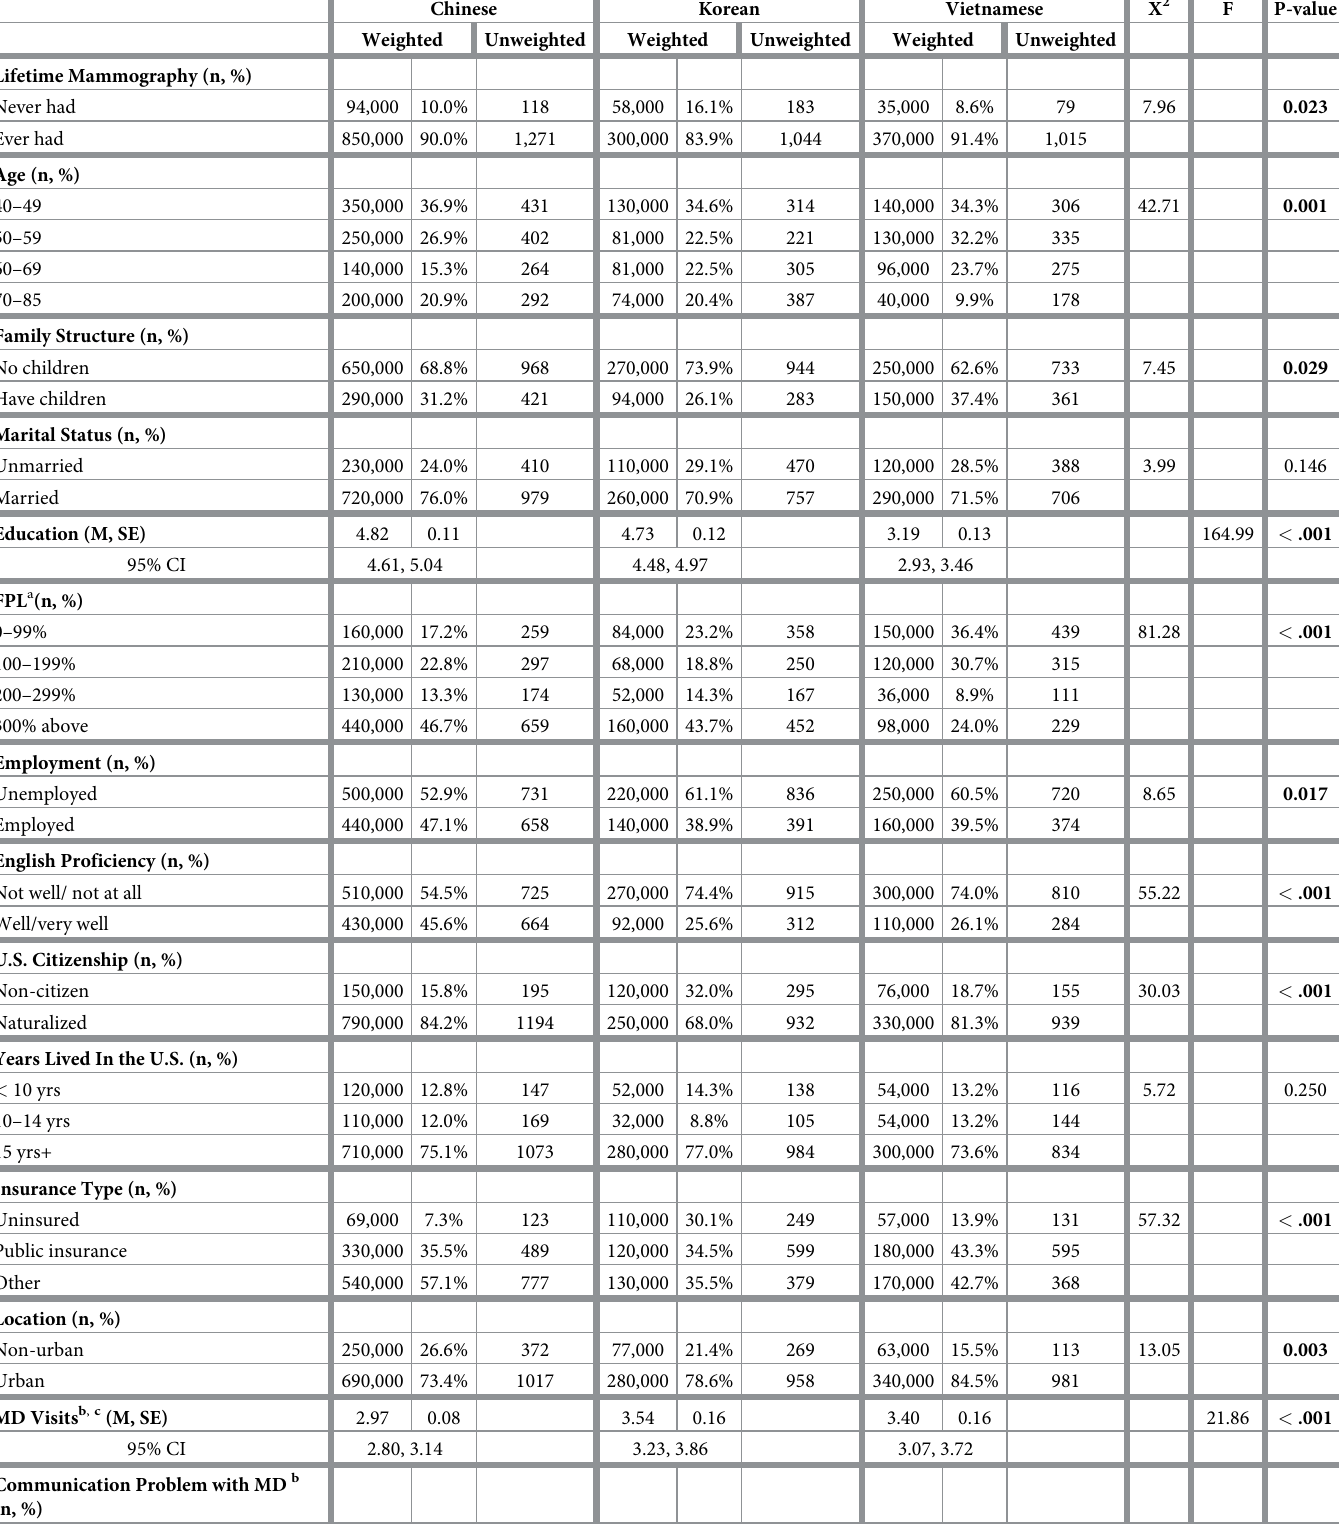
Table 2. Outcome and predictors by ethnicity (unweighted N = 3,710; weighted N =